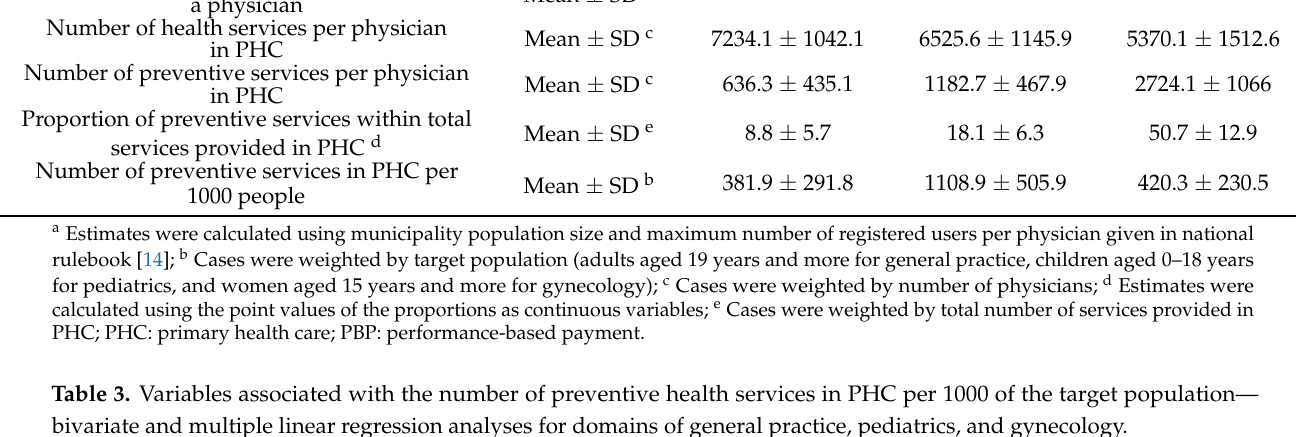
Table 3. Variables associated with the number of preventive health services in PHC per 1000 of the target population— bivariate and multiple linear regression analyses for domains of general practice, pediatrics, and gynecology.